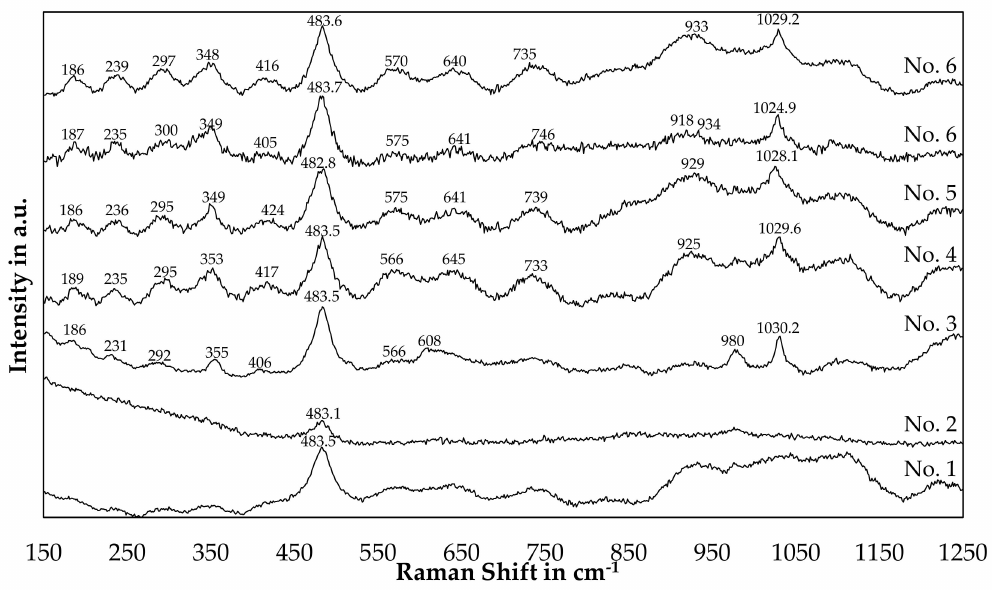
Figure 16. Raman Analysis of slag samples originated from the